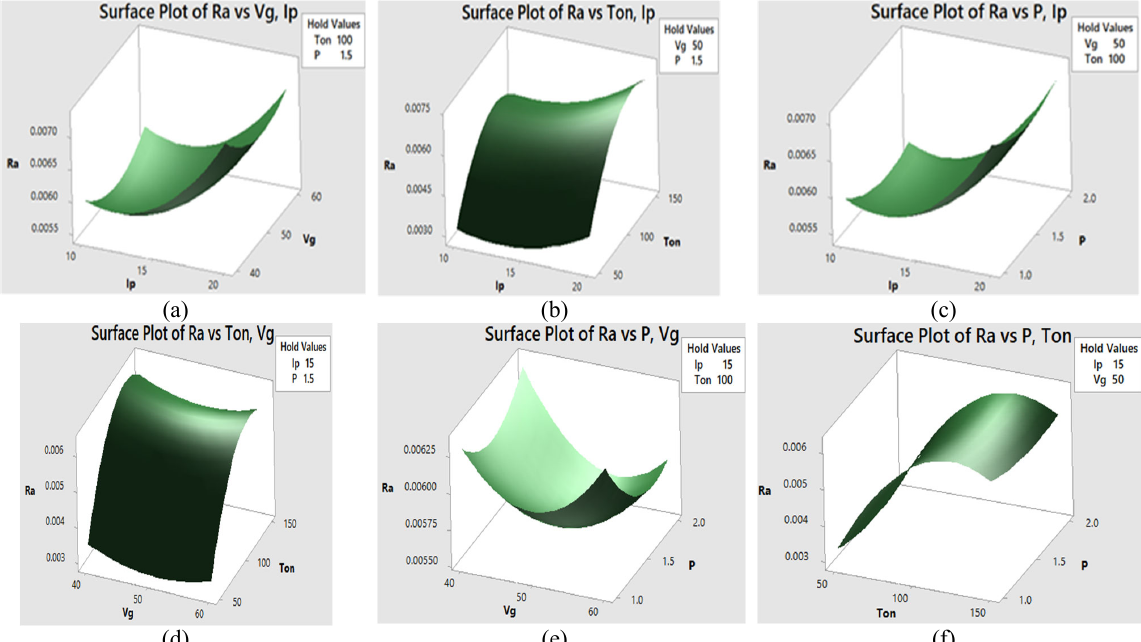
Fig. 7. 3D response surface plots showing (a) the effect of current and voltage(b) the effect of peak current and pulse on time(c) the effect of peak current and flushing pressure (d) the effect of voltage and pulse on time (e) the effect of gap voltage and flushing pressure (f) the effect of pulse on time & flushing pressure on surface roughness of Al356/WC